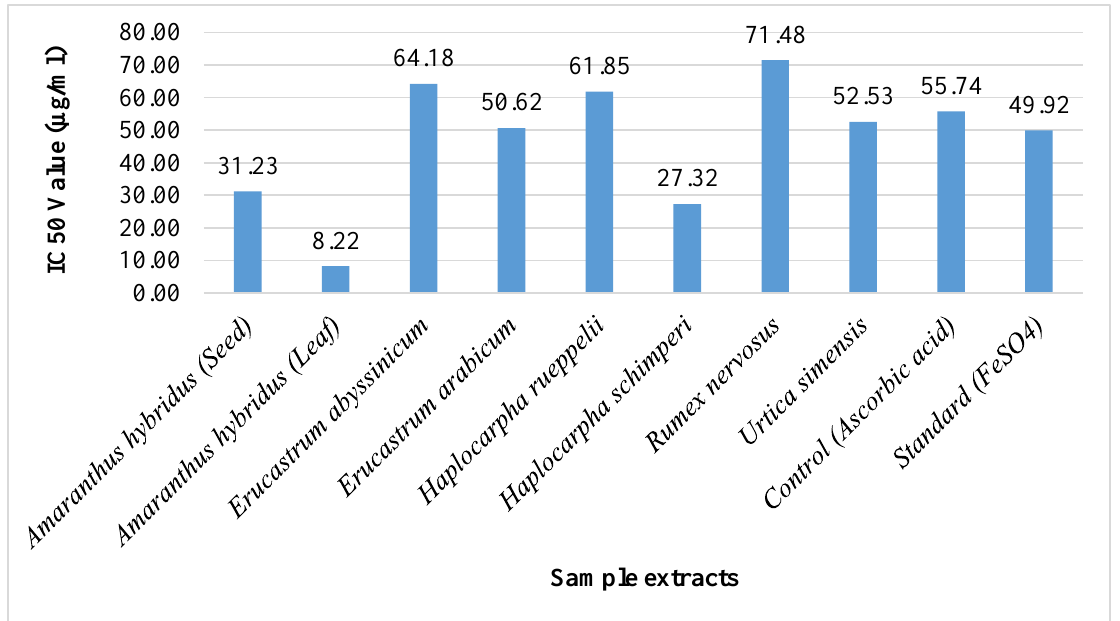
Figure 3. IC50 values in FRAP assay of WEPs.